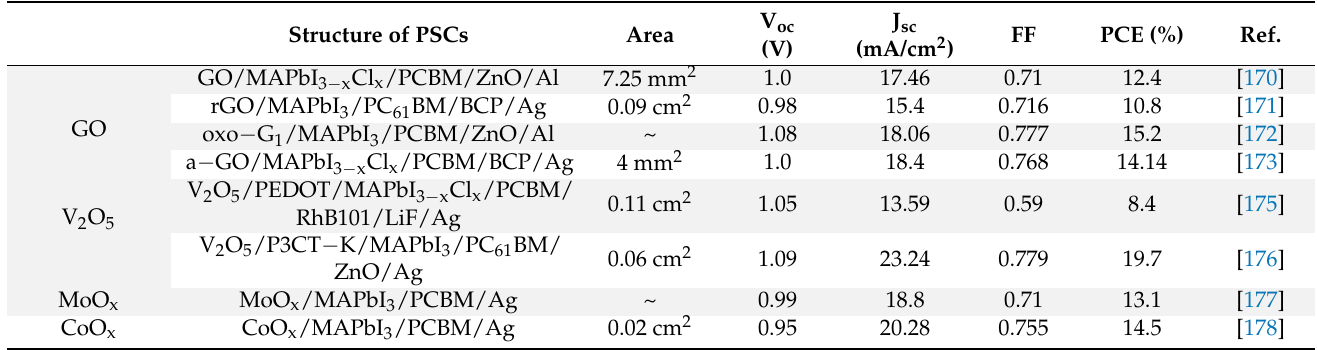
Table 16. Performances of several representative inverted PSCs on the basis of other inorganic semiconductor